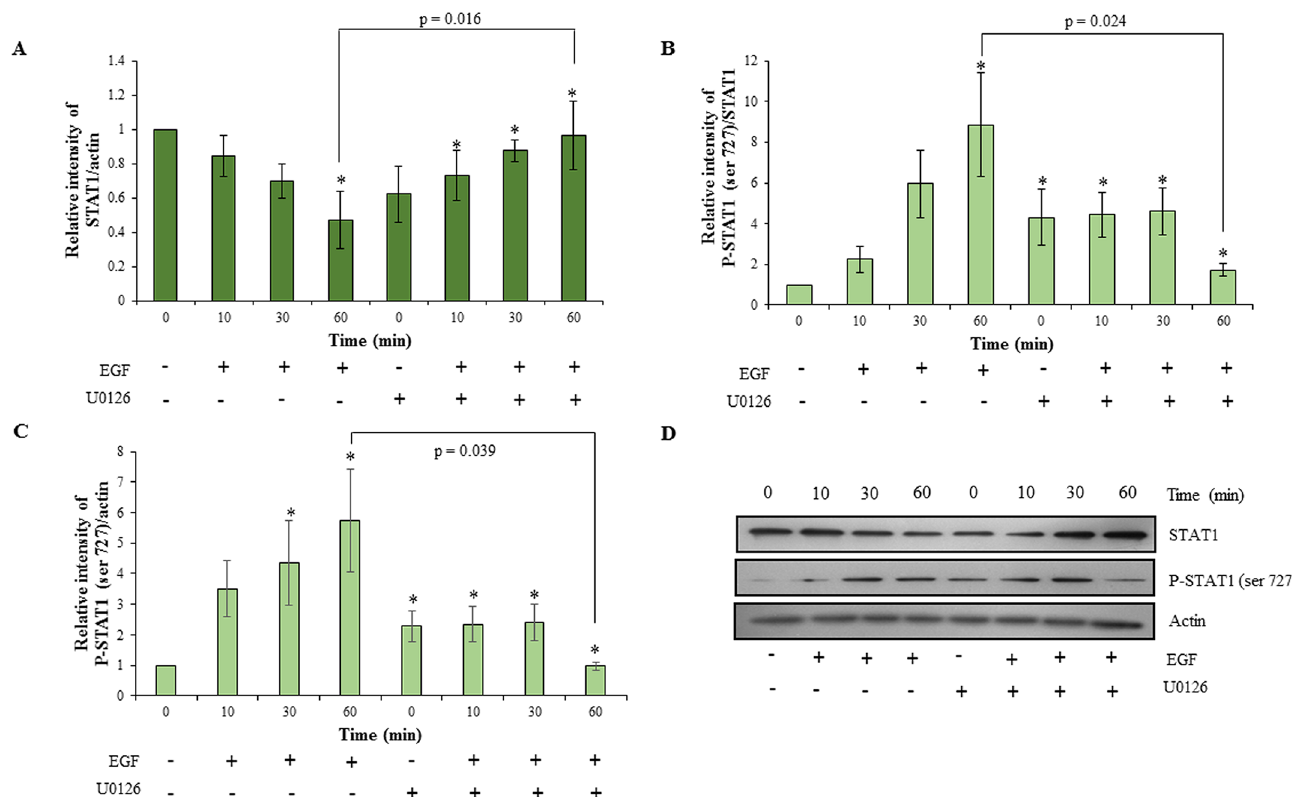
Fig 5. Effect of inhibition of ERK ½ signaling in HTR-8/SVneo cells on EGF-mediated STAT1 activation. HTR-8/SVneo cells with or without pretreatment of U0126 for 2 h, were treated with EGF (10 ng/ml) for varyingtime points (10, 30 and 60 min) and Western blotting was performed as describedin Materials and Methods . Panel A represents the densitometric profile of total STAT1 levels as comparedto actin at 10, 30 and 60 min after EGF treatment of HTR-8/SVneo cells (with or without U0126pre-treatment) with respect to untreatedcontrol respectively. Panels B and C represent the densitometric profilesof P-STAT1 ser 727 levels as comparedto STAT1 and actin respectively. Panel D shows representativeblots from one of the three independentexperiments. The data is shown as mean ± SEM of three independent experiments and band intensities were normalized with respect to loadingcontrols duringdensitometric analysis. * p < 0.05 with respect to untreated control